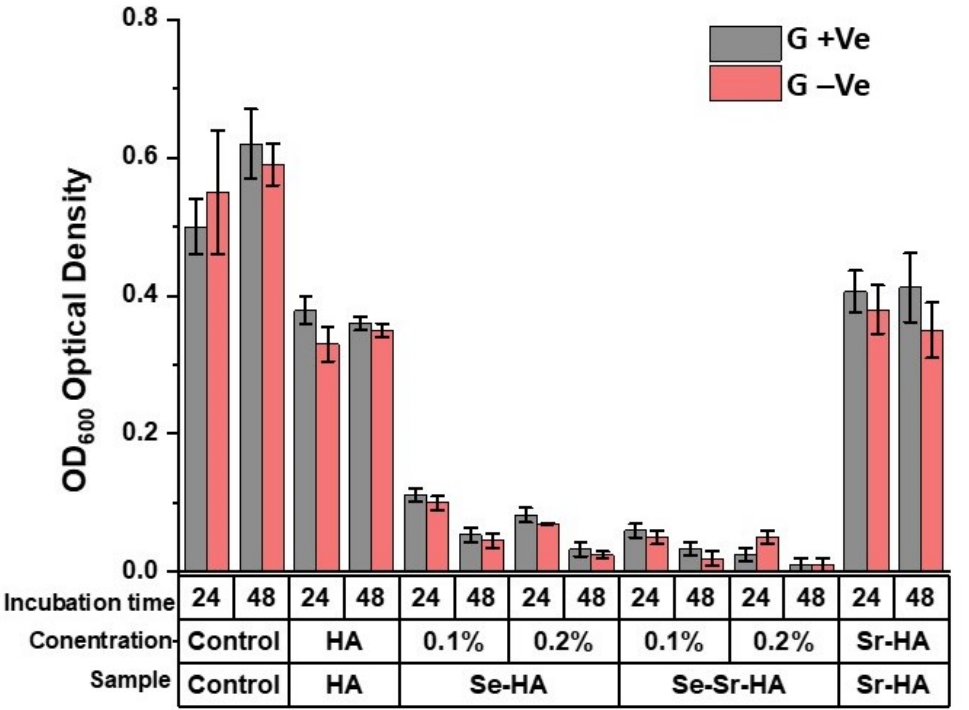
Figure 8. Bacterial turbidity (OD600) study with HA, Se-HA, and Se-Sr-HA samples by the indirect method (0.1 mg in 10 mL PBS) after 24 and 48 h of incubation against Gram+ (G+) and Gram − (G − ) bacterium (Cell suspension without HA was the negative control). Data represent mean values ± SDT of n = 5 experiments.